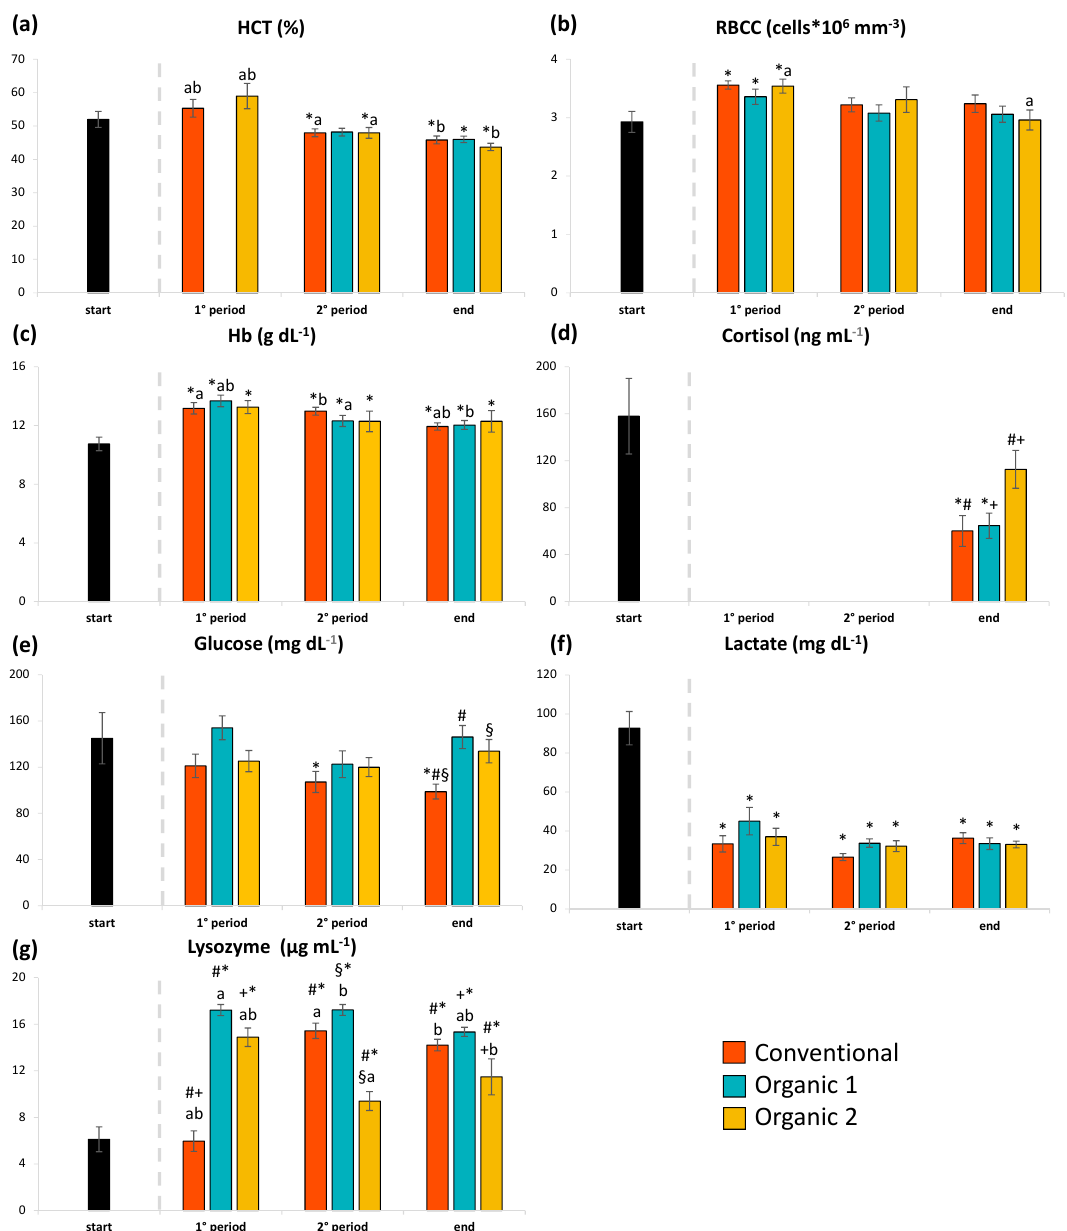
Figure 1. Mean ± SEM of the haematological and serological parameters measured over the experimental duration (start, 1° period, 2° period and end of the experiment) among the different diets. ( a ) HCT (%); ( b ) RBCC (cells 10 6 mm − 3 ); ( c ) Hb (g dL − 1 ); ( d ) Cortisol (ng mL − 1 ); ( e ) Glucose (mg dL − 1 ); ( f ) Lactate (mg dL − 1 ); ( g ) Lysozyme (µ mL − 1 ). An asterisk (*) denotes a significant difference from the “start” value. Similar symbols (#, +, §) denote significant difference in treatments comparisons.